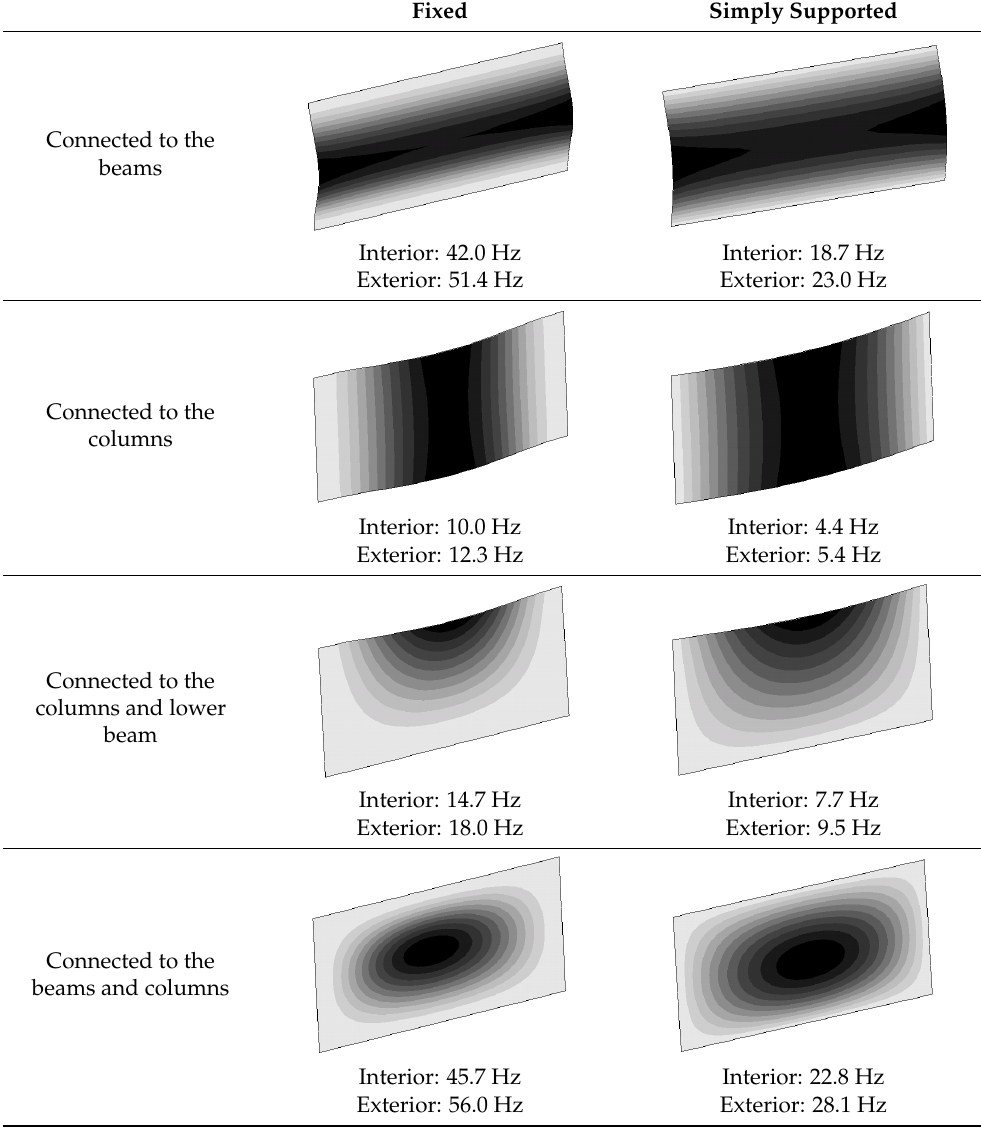
Table 8. Numerical frequencies of the solid wall (interior and exterior leaves) of model 1 (South facade) for different support conditions.